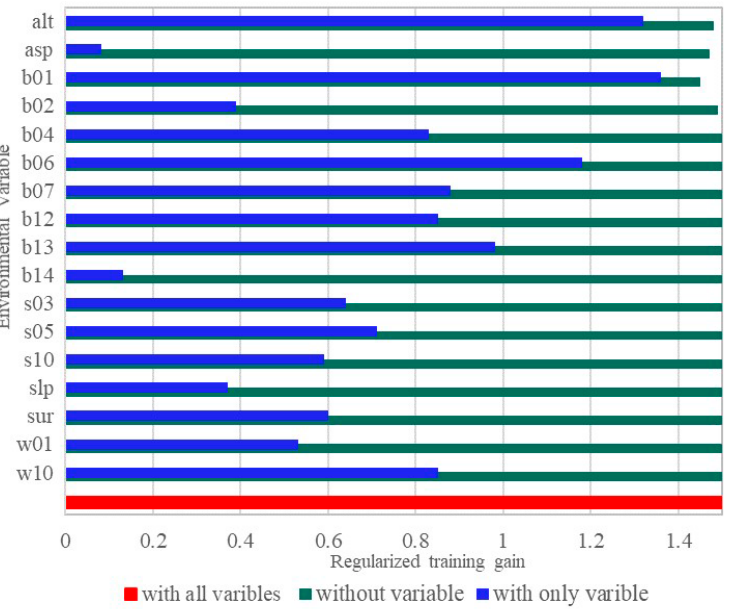
Figure 6. Results of the Jackknife test evaluating the importance for the environmental variables .